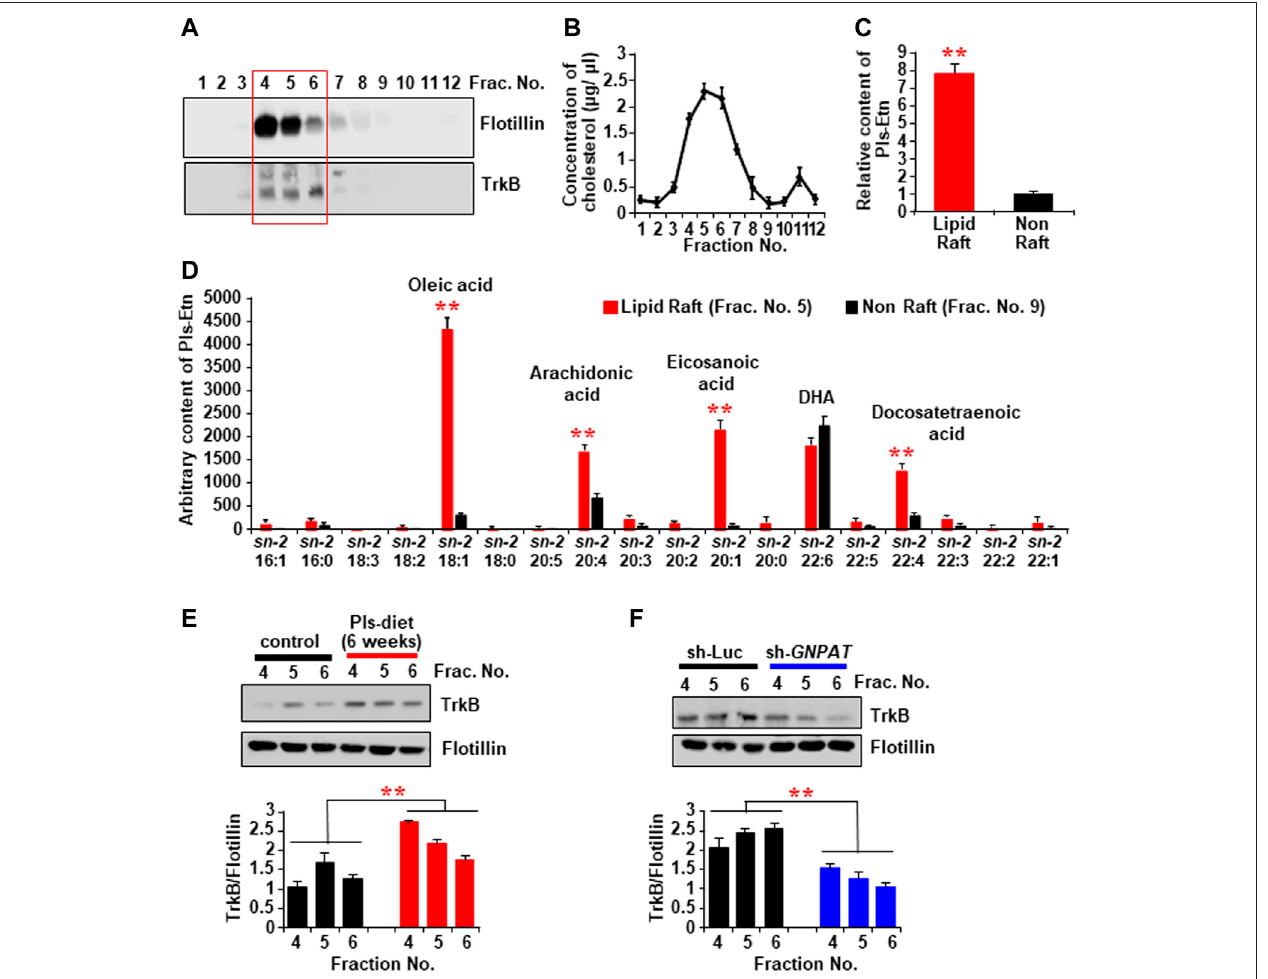
FIGURE 7 | The changes of TrkB recruitment into the lipid rafts of hippocampal tissues by the Pls diet. (A) Western blotting data show the expression of TrkB protein in the lipid raft fractions (sucrose gradient fraction no. 4, 5, and 6) of the hippocampus tissue. The Flotillin was used as a lipid raft marker. (B) Concentration of cholesterol in the sucrose gradient fractions of the hippocampus tissue. (C) LC-MS analysis shows the total Pls content in the rafts and non-raft factions of the hippocampus tissue. (D) LC-MS analysis shows the distribution of sn-2 fatty acid components of Pls in the raft and non-raft fractions. (E) Western blotting data showtheexpressionofTrkBinthelipidraftfractionsinthecontrolandPlsdietmicehippocampus. (F) TrkBcontentsinthehippocampallipidraftfractionsofcontroland sh- GNPAT group.Thedatarepresentmean±S.E.M.Thevaluesweredrawnfromthethreeindependentexperimentswithtriplicates( n =3). *, p < 0.05and **, p < 0.01. The p valuesinthepanels (C,D) werecalculatedbyStudent ’ st-testwhereasANOVAtest(followedbyBonferroni ’ sposthoctests)wasperformedtogetthesigni fi cance values in the panels (E,F) .